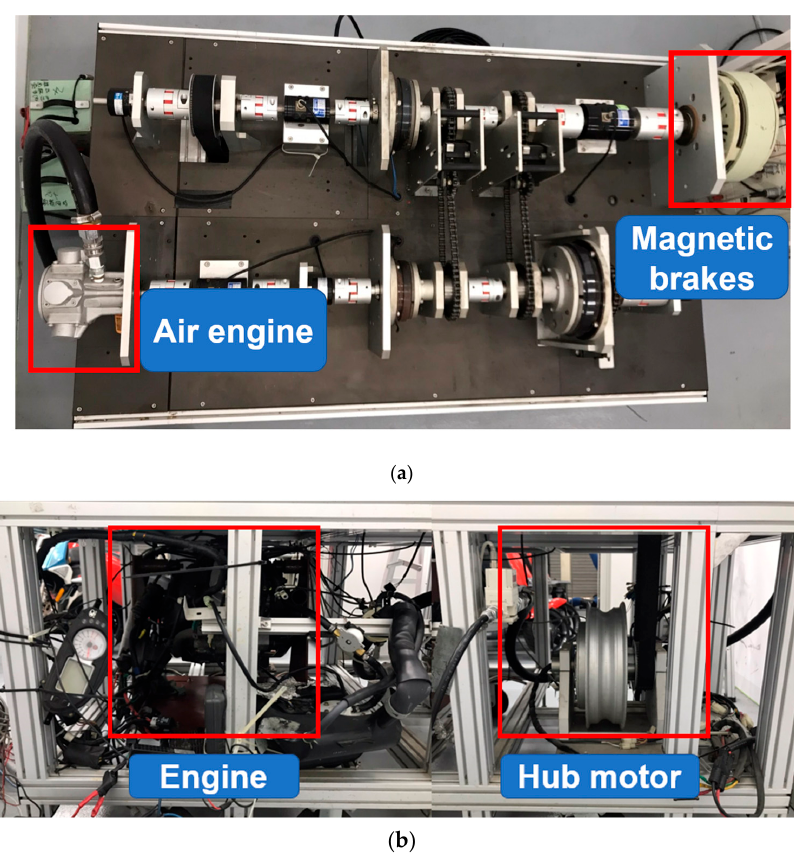
Figure 8. Three-power-source experimental platform: ( a ) top view; ( b ) side view.